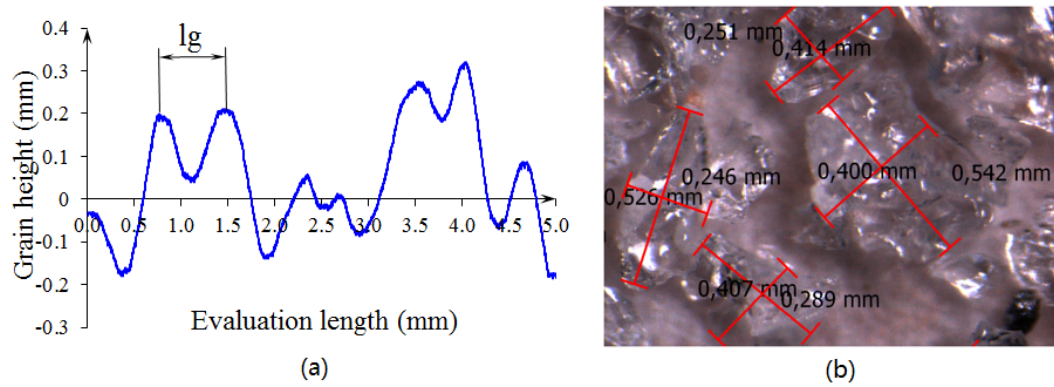
Figure 2. Characteristics of grinding wheel A36H5V: ( a ) surface-roughness profile and ( b ) size of detached grains.